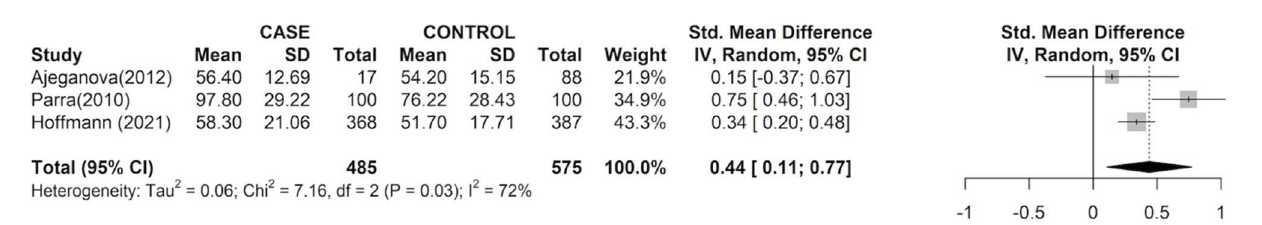
FIGURE2 Effect size between circulating oxidized low-density lipoprotein and atherosclerotic cardiovascular disease risk. Forest plots describing effect size (ES), also known as the standard mean difference, with 95% confidence interval (CI) for all included observational studies. Squares represent study-specific estimates; box sizes represent individual study weight; horizontal line represent 95% CIs; diamonds represent the total mean difference with its 95%